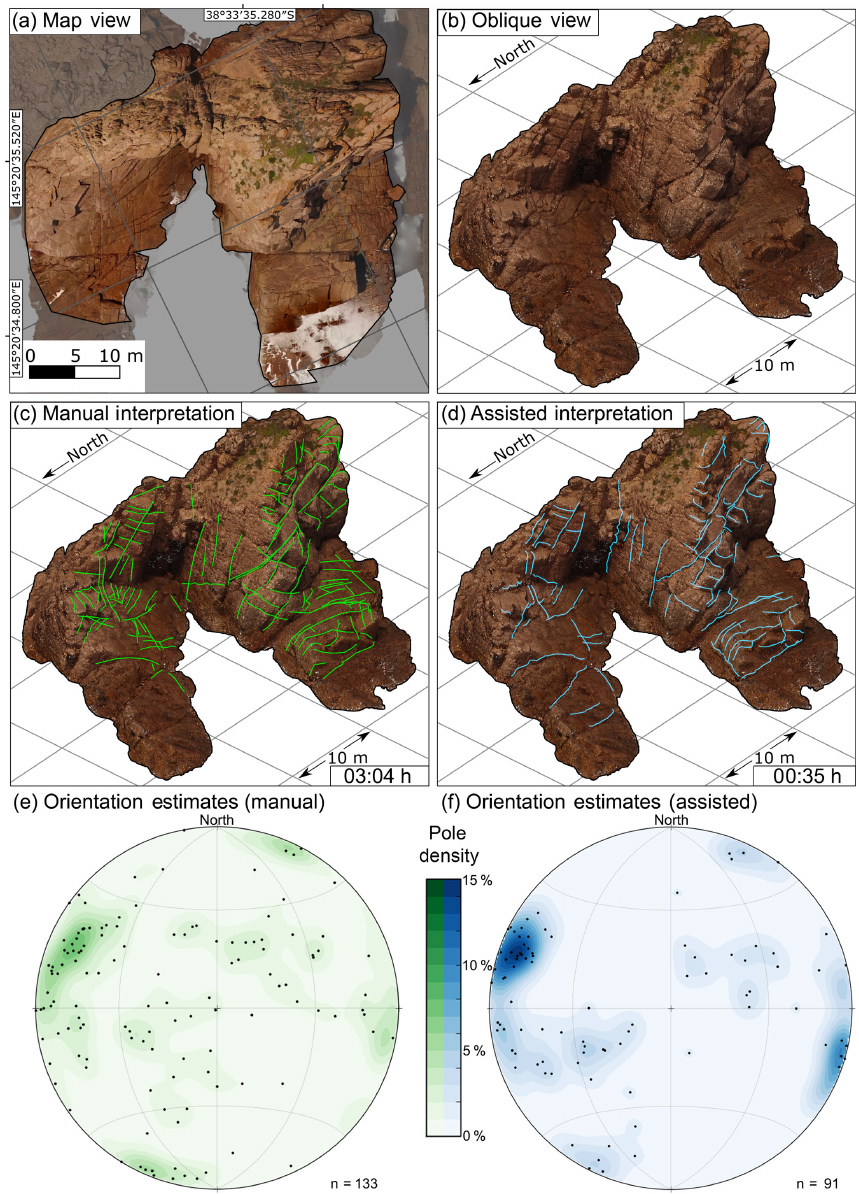
Figure 3. Orthophotograph of the Cape Woolamai sea stacks (a) and oblique view of the equivalent dense point cloud (b) . A 2.5-D analysis conducted using the orthophotograph would significantly under-sample the moderately to shallowly dipping joint sets which are clearly vis- ible on sub-vertical exposures in (b) . Hence fractures were digitised in 3-D both manually (c) and using the computer-assisted approach (d) . Equal-area lower hemisphere stereographic projections of poles to joint orientations estimated from each of these interpretations (e–f) show that both methods produce similar results. Poles from the computer-assisted dataset cluster more tightly (maximum density = 14.7%) than the manually interpreted dataset (maximum density = 8.1%), indicating that the computer-assisted approach results in more consistent ori- entation